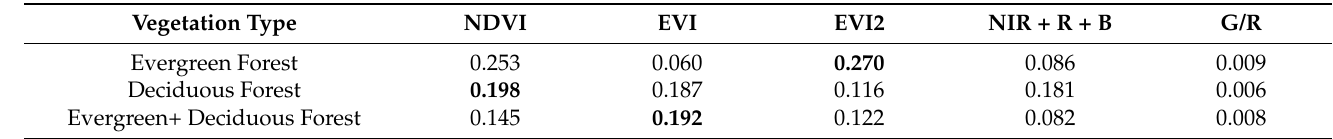
Table 2. The sensitivity coefficients of each greenness characteristic to the vegetation greenness date of spring pollen allergy.